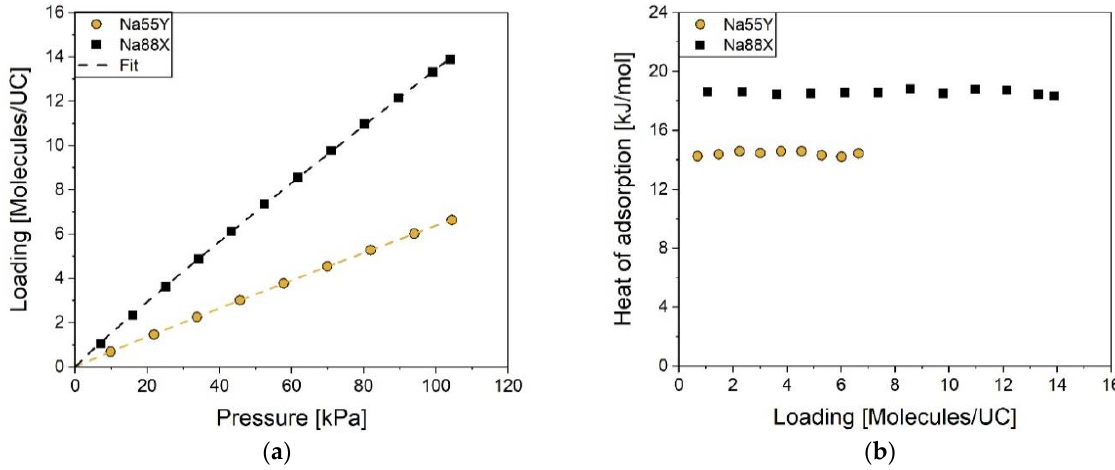
Figure 1. ( a ) Adsorption isotherms of methane on Na 88 X and Na 55 Y zeolites at 298.15 K; ( b ) Load-dependent heats of adsorption of methane on Na 88 X and Na 55 Y zeolites at 298.15 K.